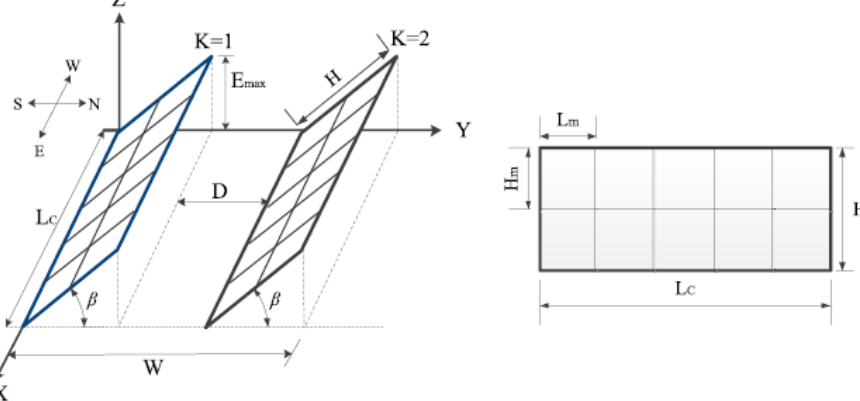
Figure 5. PV tilted system layout options based on land space constraint in system sizing [3].